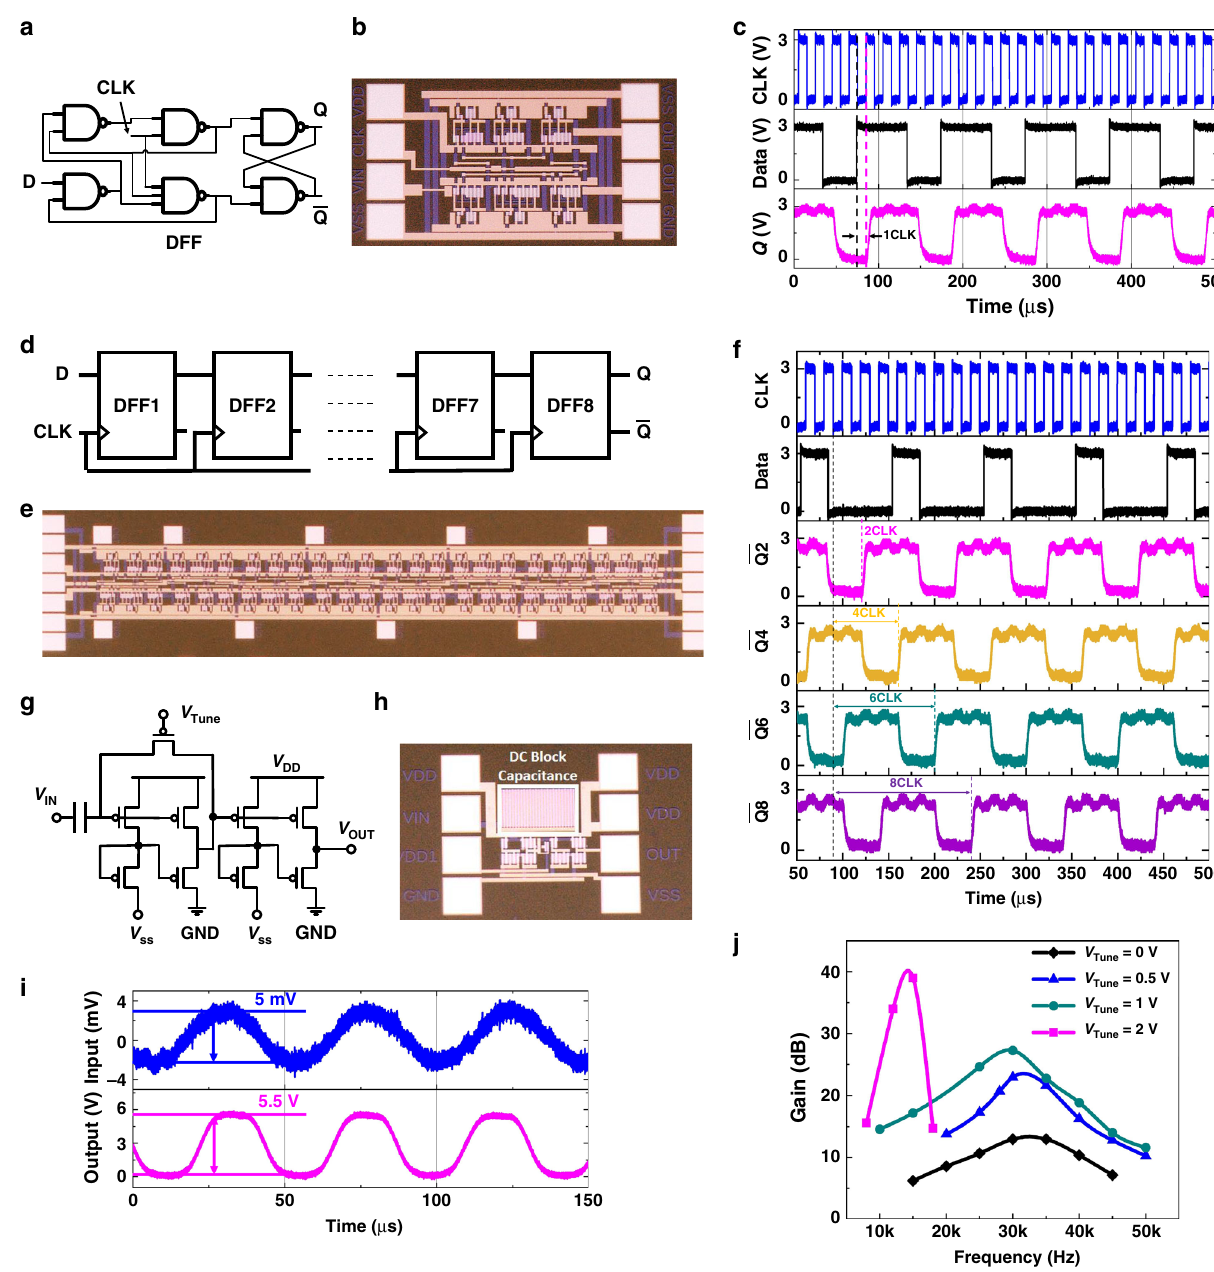
Fig. 4 Flexible pseudo-CMOS sequential circuits and self-biased tunable gain ampli fi er. a , b Circuit diagram and die photo of a positive edge triggered D fl ip- fl op (DFF). c Measured waveforms of a DFF with clock rate of 50 kHz and data rate of 10 kHz. L = 10 µ m, V and die photo of an eight-stage shift register consisting of 304 CNT TFTs. f Measured waveforms of an eight-stage shift register with CLK running at 50 kHz and input data running at 10 kHz. L = 10 µ m, V DD = 3 V, V SS = − 3 V. g , h Circuit diagram and die photo of a self-biased tunable ampli fi er. i Measured waveforms of a tunable-gain pseudo-CMOS ampli fi er with 5 mV input and ~5.5 V output at ~20 kHz and V TUNE = 3 V indicating a high gain